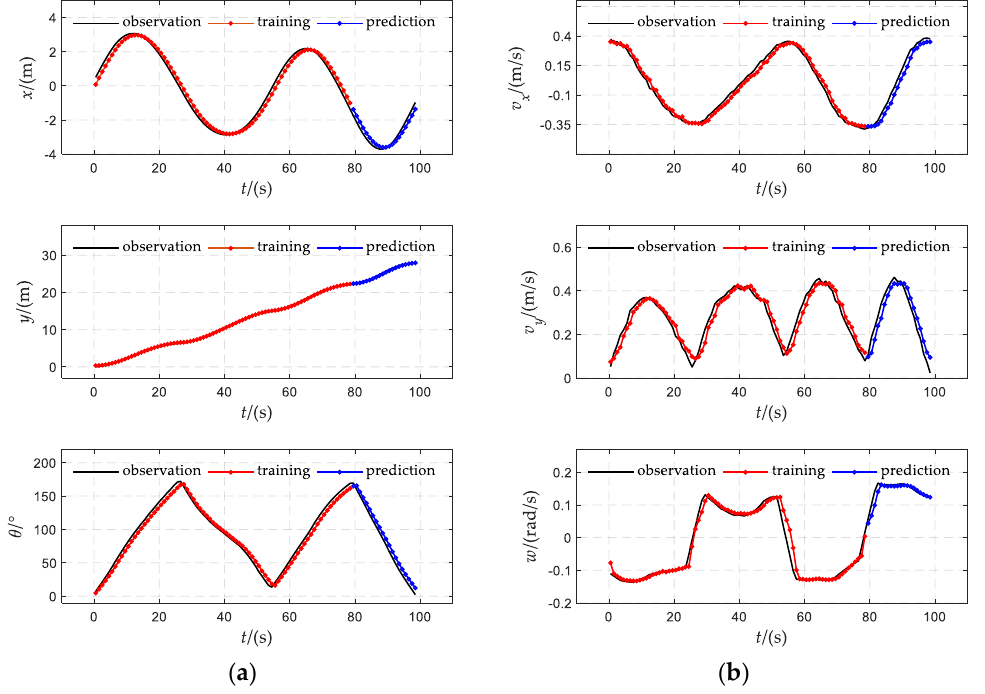
Figure 14. Results of training and prediction of the scaled test prototype. ( a ) Results of traning and prediction of position and path angle; ( b ) Results of traning and prediction of velocity and angular velocity. Table 4. Results of prediction accuracy of scaled test prototype.